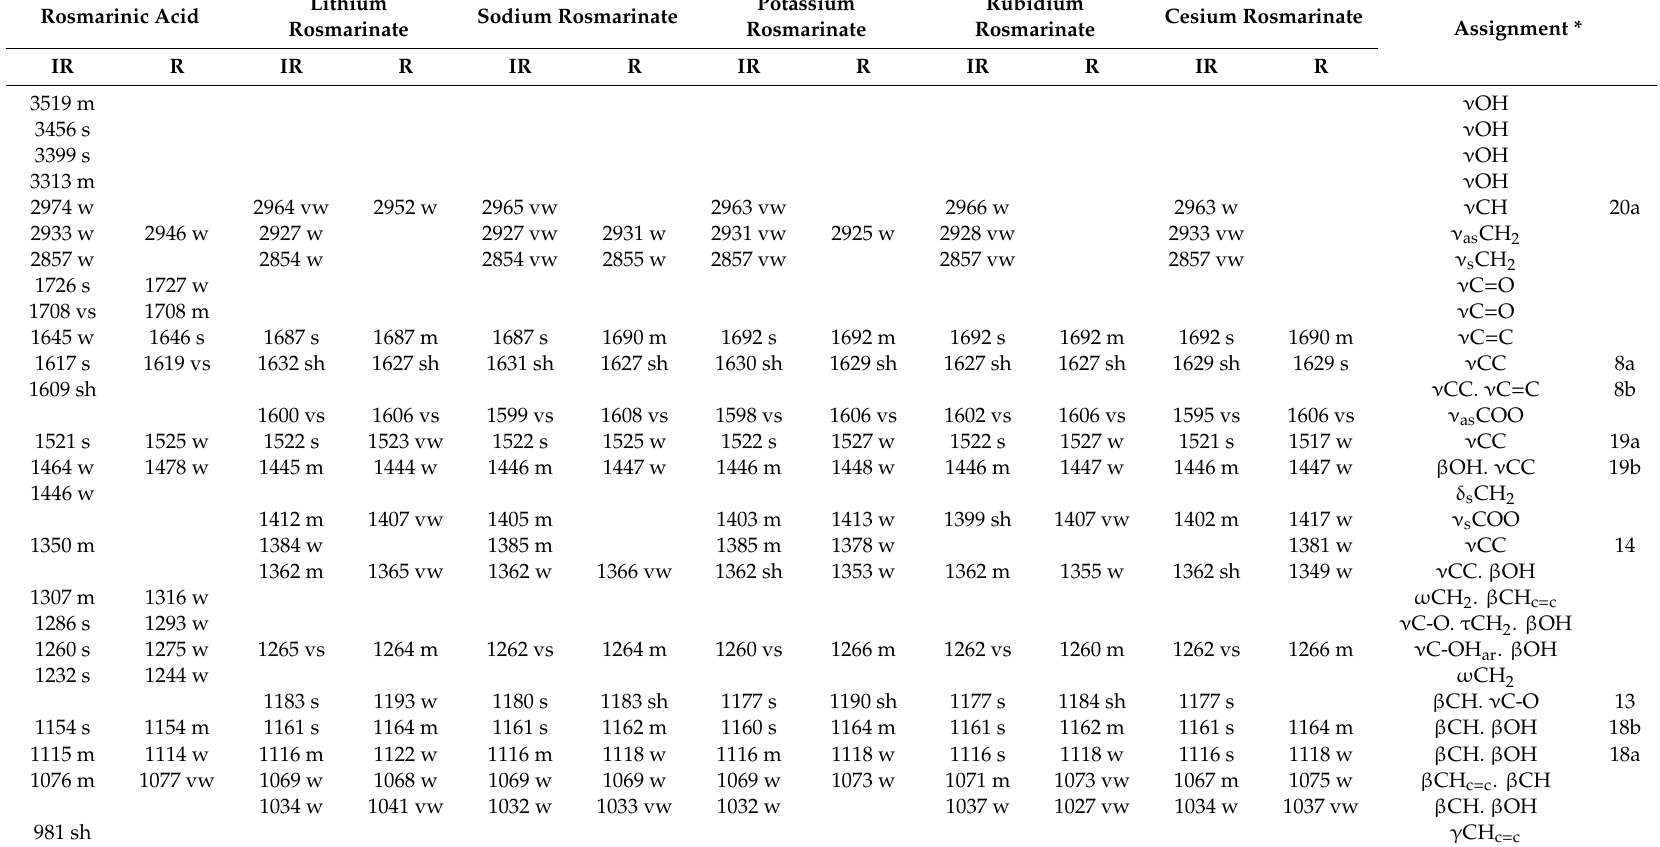
Table 5. The wavenumbers (cm − 1 ) and intensities (Int) of vibrational spectra of alkali metal